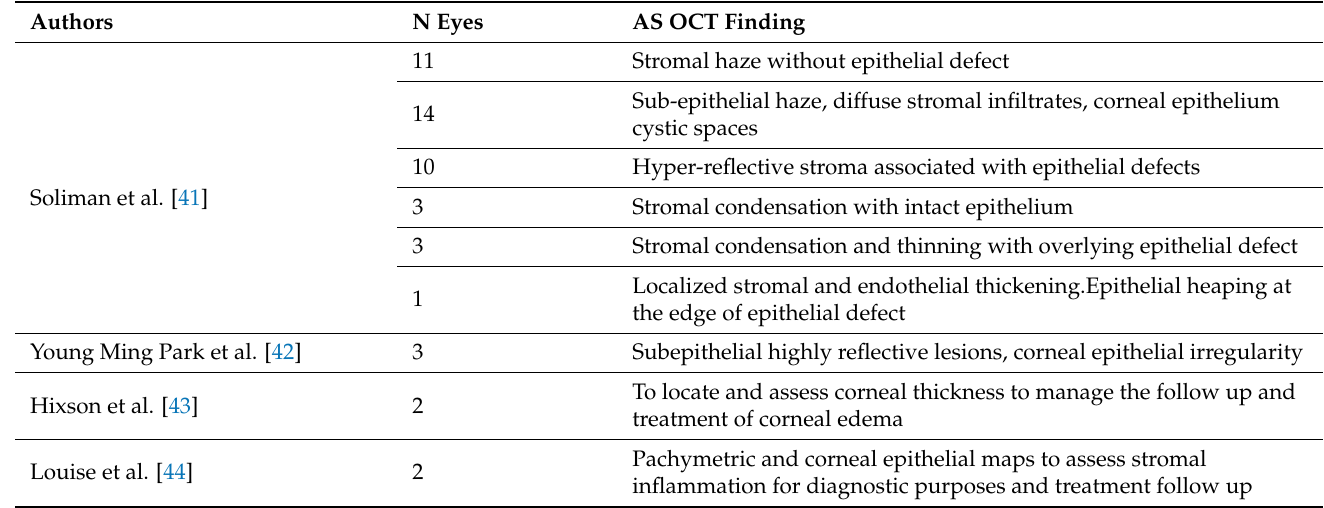
Table 1. Clinical characteristics of eyes in studies analyzing the cornea using anterior segment-OCT